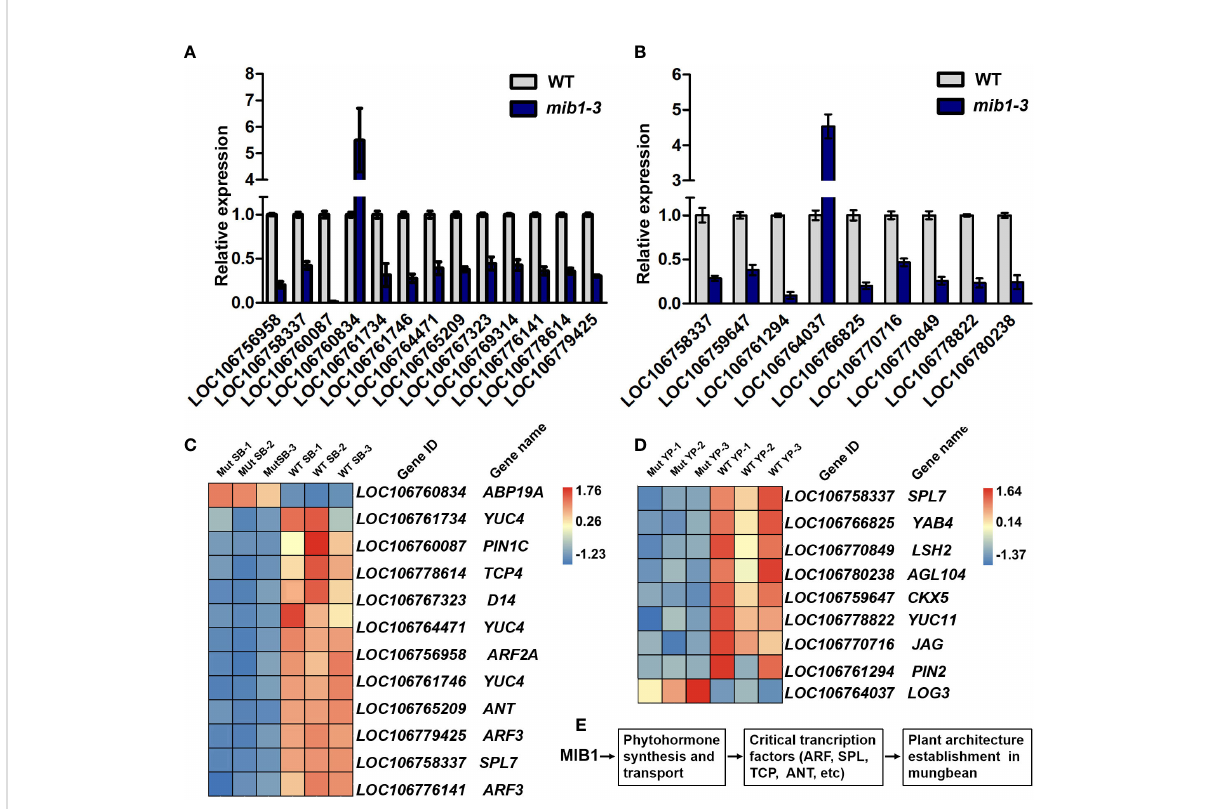
FIGURE 8 Critical DEGs involved in the control of plant architecture in mungbean. (A) qRT-PCR analysis of 13 DEGs in the shoot buds between WT and mib1 mutants. (B) qRT-PCR analysis of eight DEGs in young pods between WT and mib1 mutants. (C) Heat map showing critical DEGs involved in the control of the rate of leaf production, branch number, and organ size. (D) Heat map showing critical DEGs in involved young pod development. (E) A hypothetical model of MIB1 affecting plant architecture in